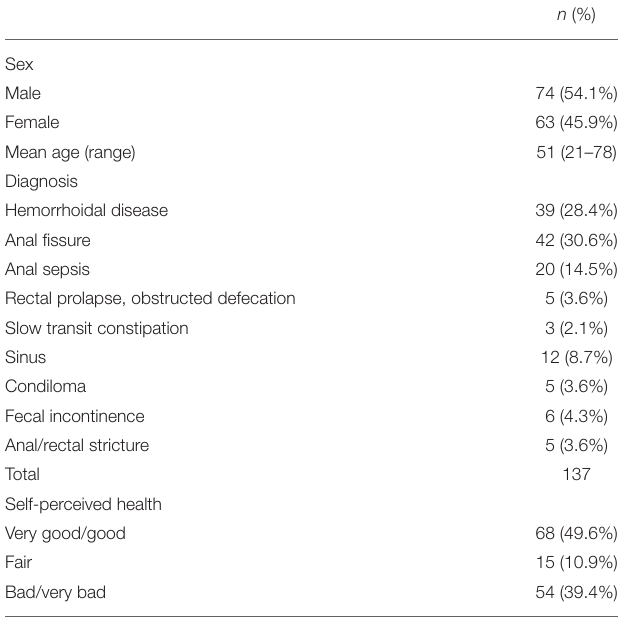
TABLE 4 | Clinical features of patients available at interview ( n = 137).